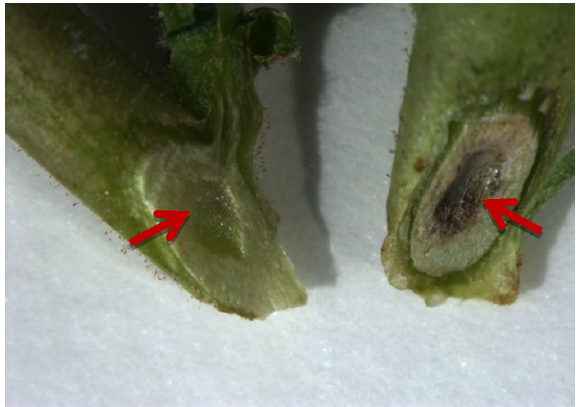
Figure 3. Stem discoloration of a chickpea plant artificially infected by Foc. Healthy plant on the